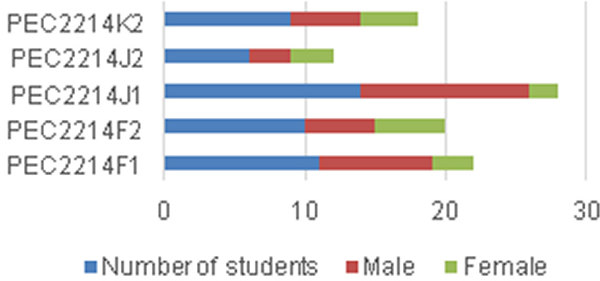
Fig. 1. Percentage of male and female students in each